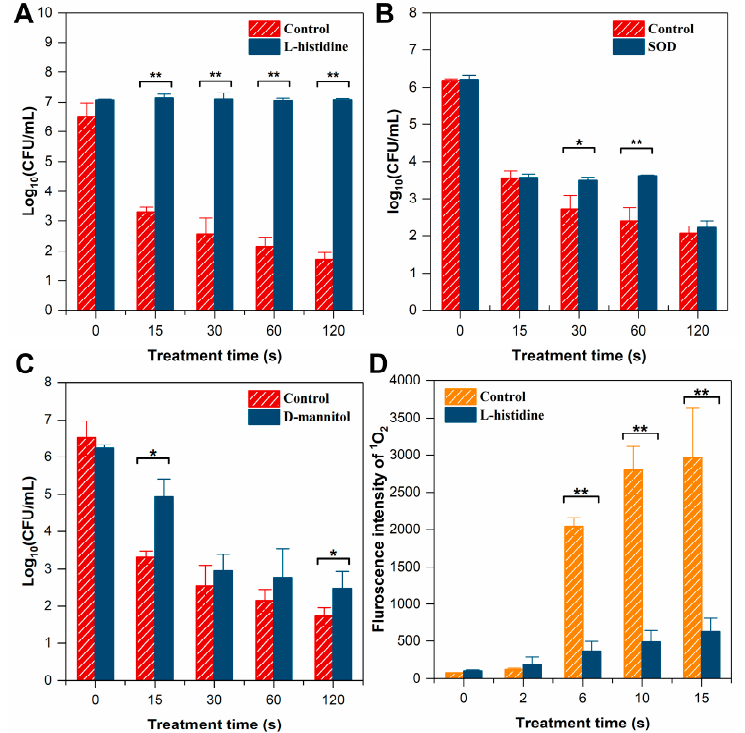
Figure 3. Experiments for scavenging singlet oxygen ( 1 O 2 ), superoxide anion (•O 2 - ), and hydroxyl radical (•OH) by 1 M L-histidine ( A ), 500 U SOD ( B ), and 1 M D-mannitol ( C ), respectively. The positive experiments for validating the concentration of singlet oxygen with SOSG (10 μ M) and with or without 1 M L-histidine are shown in ( D ). The cold plasma voltage was set at 1.32 kV and the gas flow rate was set at 130 mL/min. All experiments were repeated in triplicate. One-way ANOVA was used for calculating statistical significance. *, p < 0.05; **, p < 0.01.